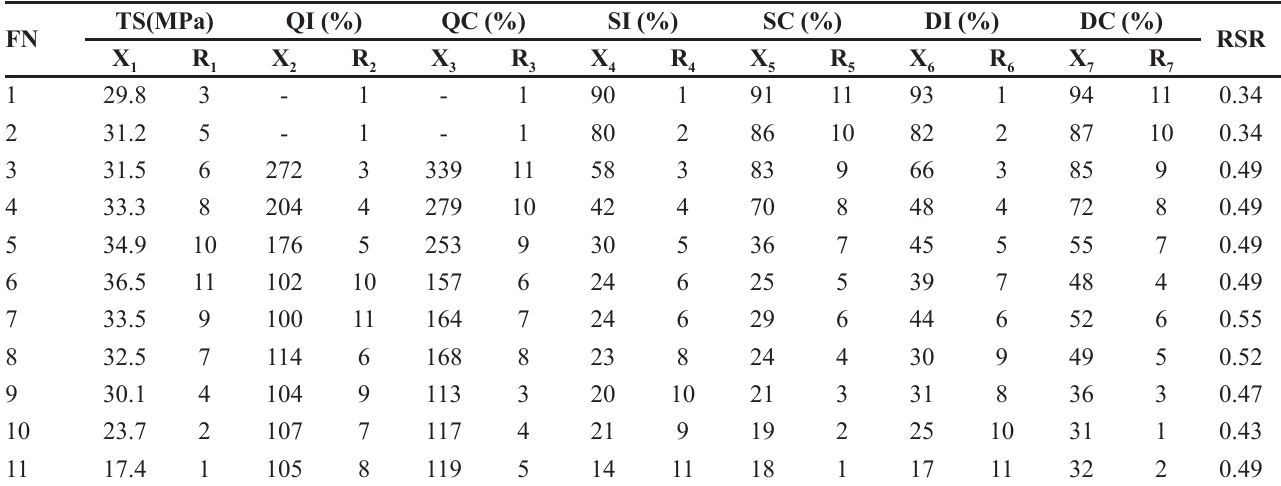
TABLE III - Results of the RSR